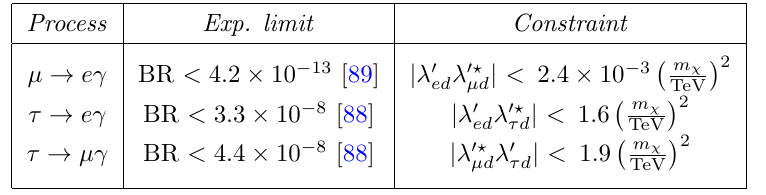
Table 13 . Constraints on the Yukawa couplings (cid:21) 0 as a function of the singlet LQ mass from ‘ (cid:11) ‘ (cid:12) (cid:13) !